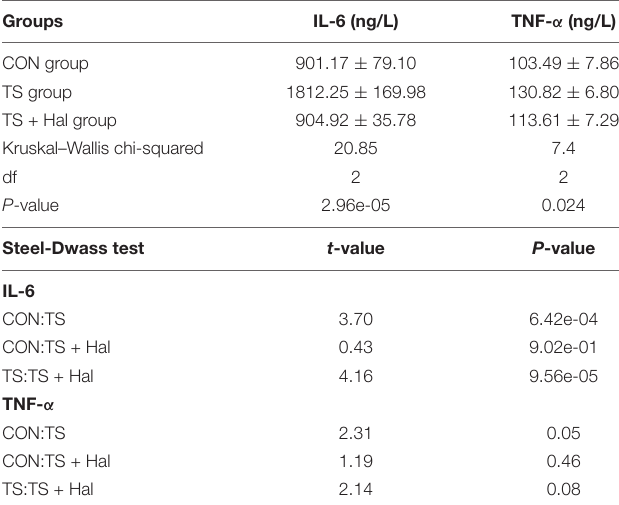
TABLE 2 | Comparison of IL-6 and TNF- α levels in each